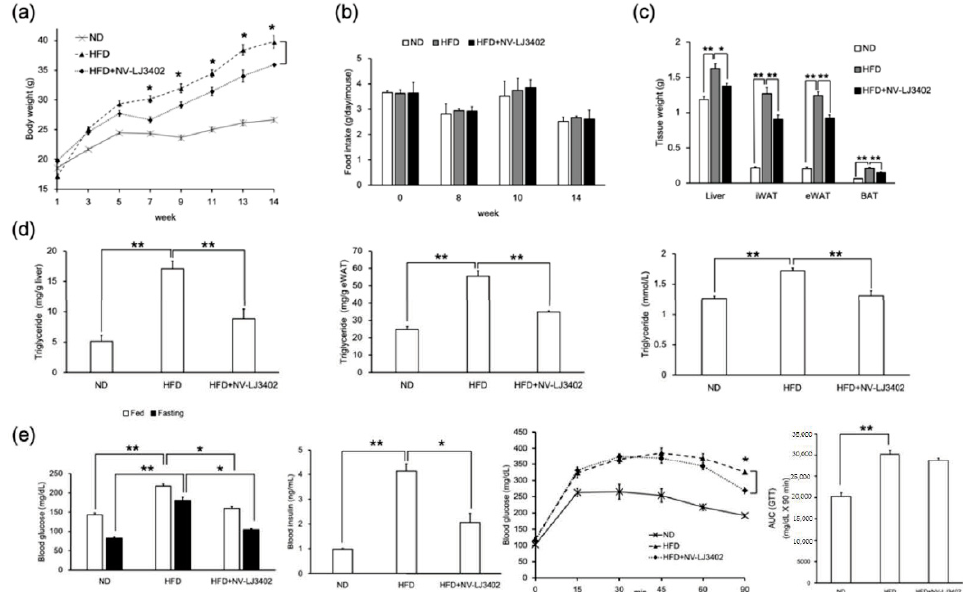
Figure 1. Non-viable Lactobacillus johnsonii JNU3402 (NV-LJ3402) attenuates diet-induced obesity in high fat diet (HFD)-fed mice. Seven-week-old C57BL/6J male mice were administered NV-LJ3402 or Phosphate-buffered saline (PBS) daily for 14 weeks during feeding with a normal diet (ND) or an HFD, and body weight gain ( a ) of mice was measured as indicated. ( n = 7 per group). HFD vs. HFD + NV-LJ3402, * p < 0.05. Daily Food intake ( b ) was measured three times per indicated week, and tissue weights at the 14th week of feeding ( c ) were measured (B-C, n = 6–7 per group). ( d ) Triglyceride (TG) levels in the tissues (liver and epididymal WAT (eWAT)) and plasma ( n = 6–7 per group). ( e ) Plasma glucose, insulin levels, and glucose tolerance test results from each group of mice after 14 weeks of feeding ( n = 7 per group). All data are expressed as the mean ± S.E.M. ND vs. HFD, HFD vs. HFD + NV-LJ3402, * p < 0.05, ** p < 0.01.